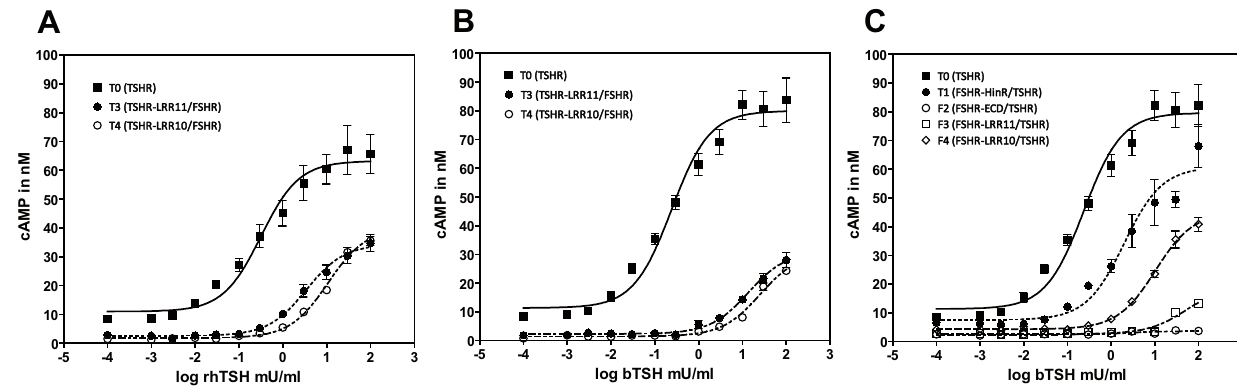
Figure 2. Dose-response curves of the G s pathway with increasing concentrations of rhTSH (A) or bTSH (B and C). Data are presented as means 6 SD of at least three independent experiments, each carried out in duplicates. EC 50 were calculated using the GraphPad Prism 4.0 software for windows applying the nonlinear curve fit module. doi:10.1371/journal.pone.0111570.g002 domain. The shorter LRR domain results in an accumulation of side of the LRR domain at LRR 10 and 11 showed that there negative charges in construct T4 (E251 from LRR10 of the are marked differences between the FSHR and the TSHR TSHR and E266 from LRR11 of the FSHR) and positive (Figure 3A). While positive charges dominate this area in the charges in construct F4 (K243 and R245 from LRR10 of the FSHR, uncharged and negatively charged patches prevail in the FSHR and R274 from LRR11 of the TSHR) (Figure 3B and C). TSHR. The charge distribution of the chimeras with 11 LRRs of the respective receptors (T1, T3 and F1, F3) closely resembles the distribution of the wt receptors with the matching LRR